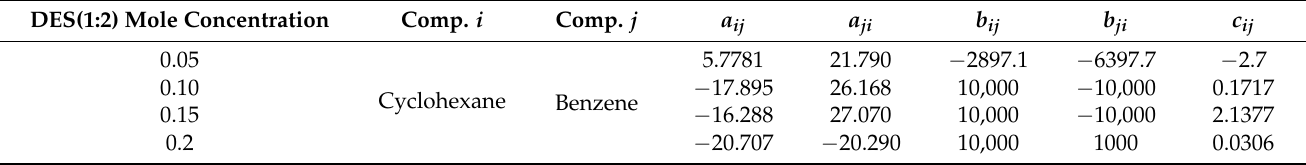
Table 11. Estimated values for the binary parameters using the NRTL model for correlating the pseudo-binary VLE data.